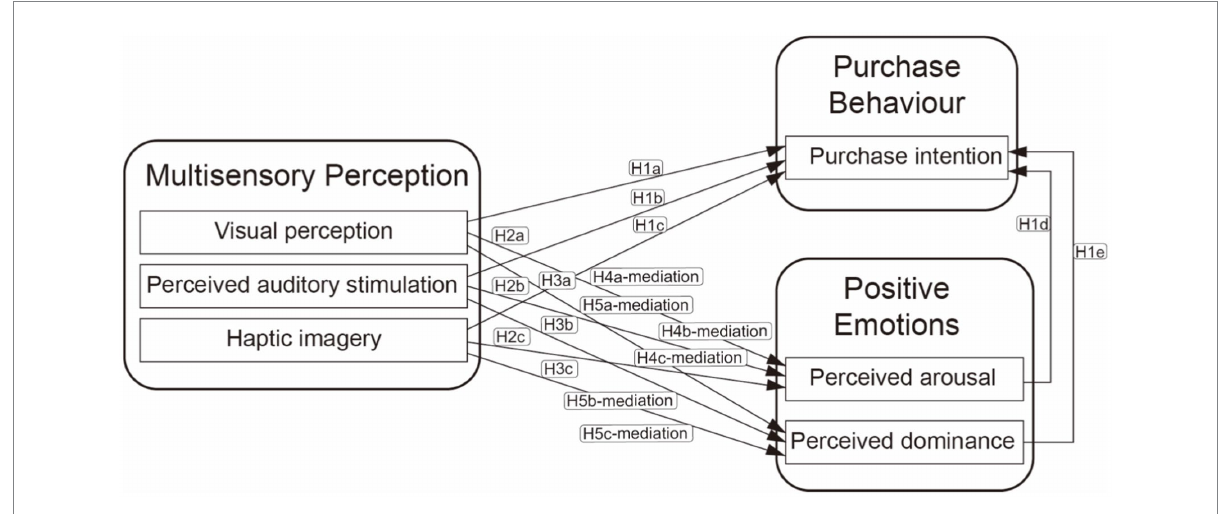
FIGURE 1 Multisensory perception, positive emotions, and purchase behaviour in an e-customisation (MPP-E) conceptual